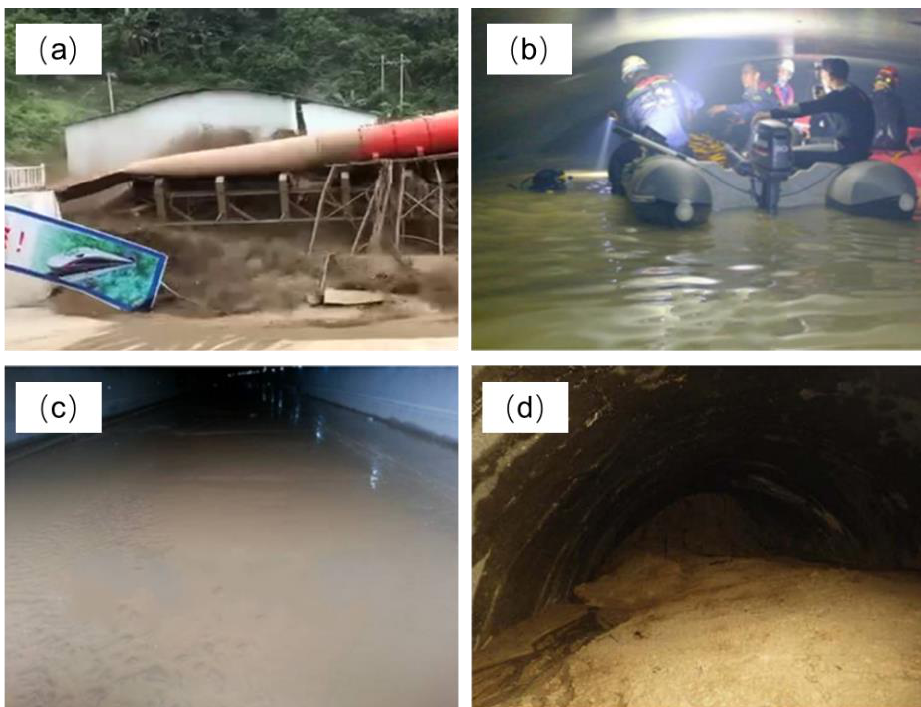
Figure 1. Water inrush in tunnels: ( a ) Chaoyang Tunnel [8]; ( b ) Shijingshan Tunnel [9]; ( c ) Shangjia- wan Tunnel [10]; ( d ) Denghuozhai Tunnel [11].